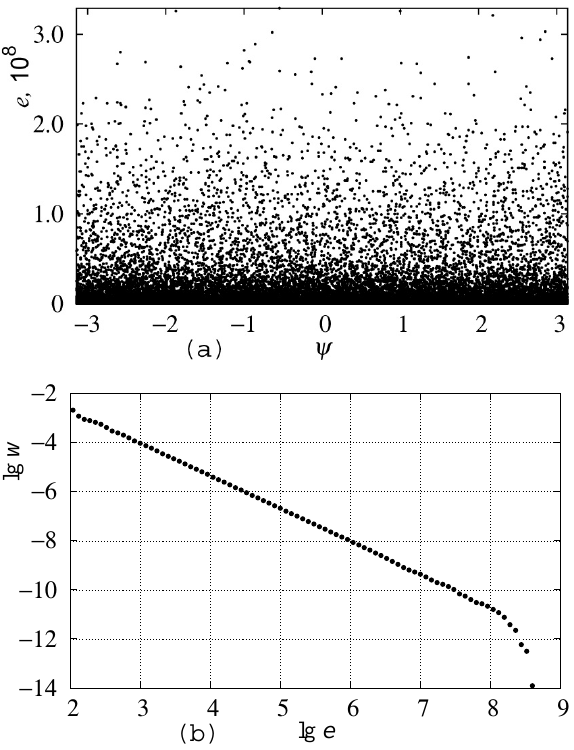
Fig. 11. (a) Phase space e − ψ and (b) the energy distribution w(e) for the map (110) with parameters Q = 9 . 2, α = 10 − 21 , and e c = 10 2